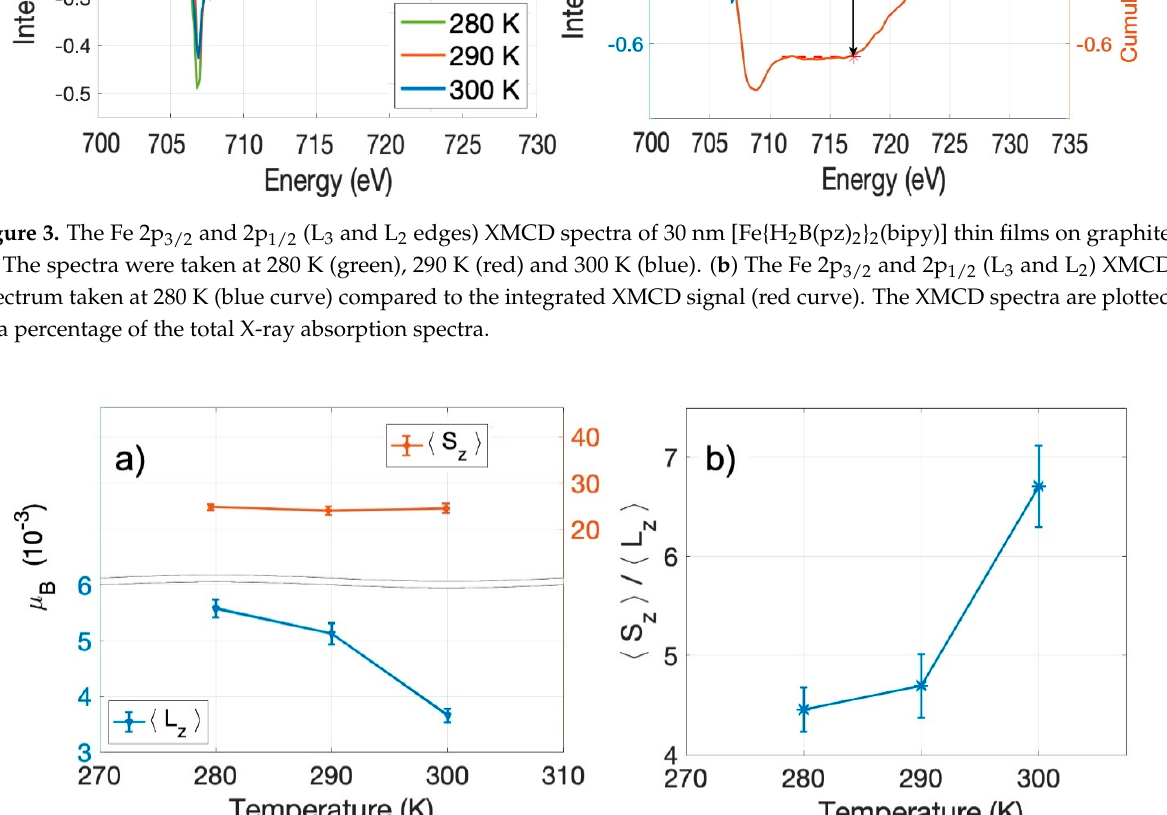
Figure 4. The temperature dependence of the relative spin S z and orbital L z moments extracted from Fe (II) XMCD taken from a 30 nm [Fe{H 2 B(pz) 2 } 2 (bipy)] thin film on graphite. ( a ) The temperature-dependent spin moment (red plot) and orbital moment (blue plot) of Fe (II). ( b ) The ratio of spin moment S z to orbital moment L z as a function of temperature in the vicinity of room temperature.